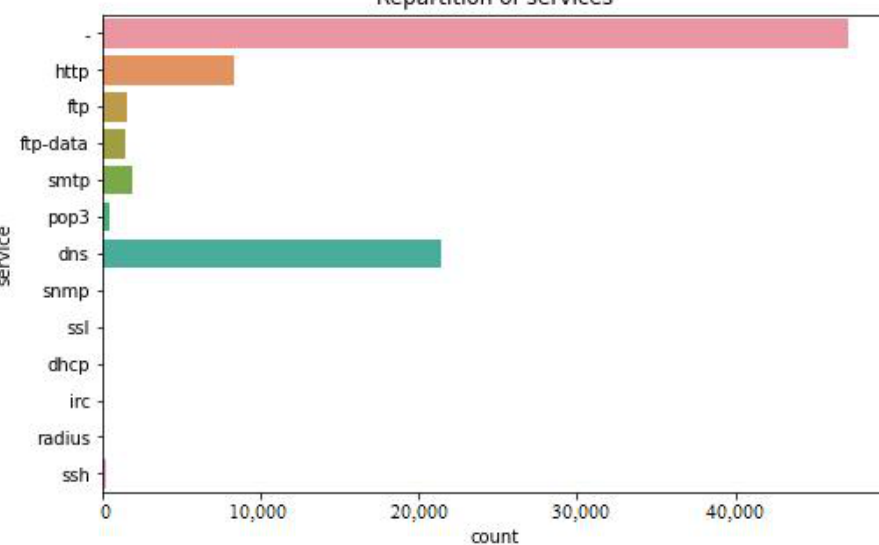
Figure 5. Repartition of services in